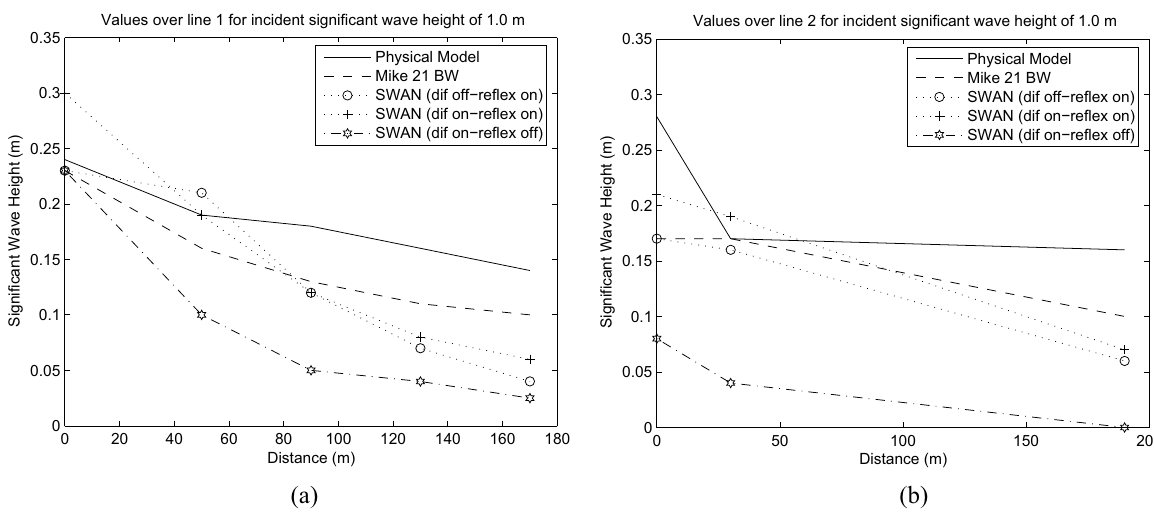
Fig. 7 – Significant wave height measured in the physical model and estimated by the models MIKE 21 BW and SWAN with reflection on for: diffraction off (dif off—reflex on) and diffraction on (dif on—reflex on). The values for reflection off and diffraction on (dif on—reflex off) are also shown. For incident significant wave height of 1.0 m; over Line 1 (a) and over Line 2